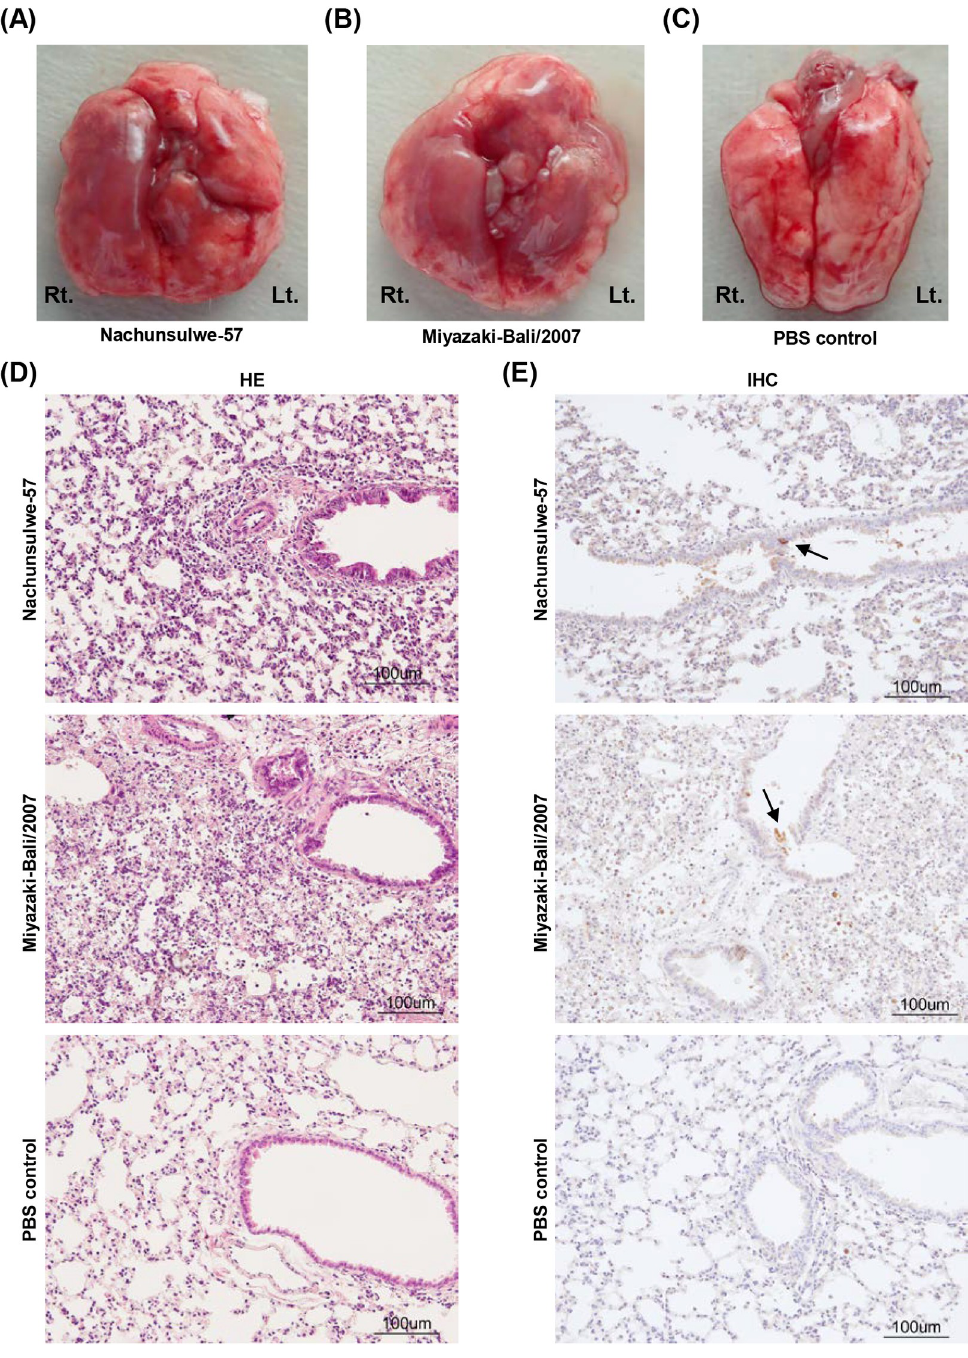
Fig 6. Pathological examination of BALB/c mice infected with Nachunsulwe-57 and Miyazaki-Bali/2007. The lungs were collected from BALB/c mice infected with Nachunsulwe-57 (10 6 PFU; A) or Miyazaki-Bali/2007 (10 6 PFU; B) at 4 dpi and control mice receiving PBS (C). Macroscopic images of the lungs were captured from the dorsal side. Lt, left lung; Rt, right lung. (D) HE staining images of the lungs of BALB/c mice at 4 dpi (magnification 200 × , scale bars = 100 μ m). (E) IHC analysis of the lungs at 4 dpi were performed using the anti-PRV polyclonal antibody. Black arrows indicate bronchiolar epithelial cells with immuno-positive signal for PRV (magnification 200 × , scale bars = 100 μ m).